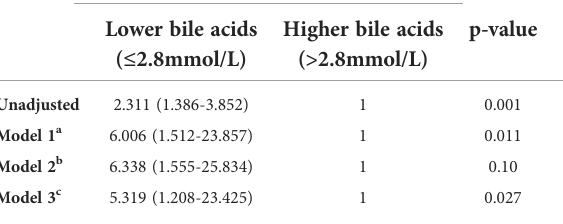
TABLE 3 Associations between bile acid levels and renal